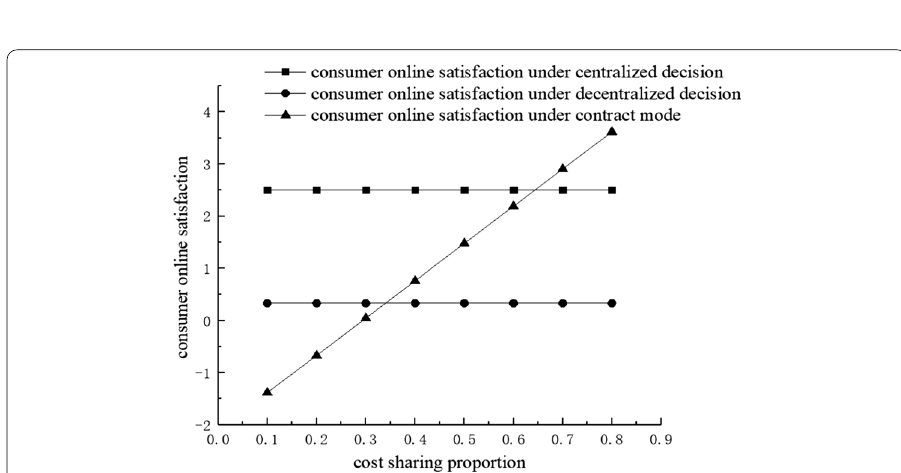
Fig. 9 Change of consumer online satisfaction S 1 with cost share